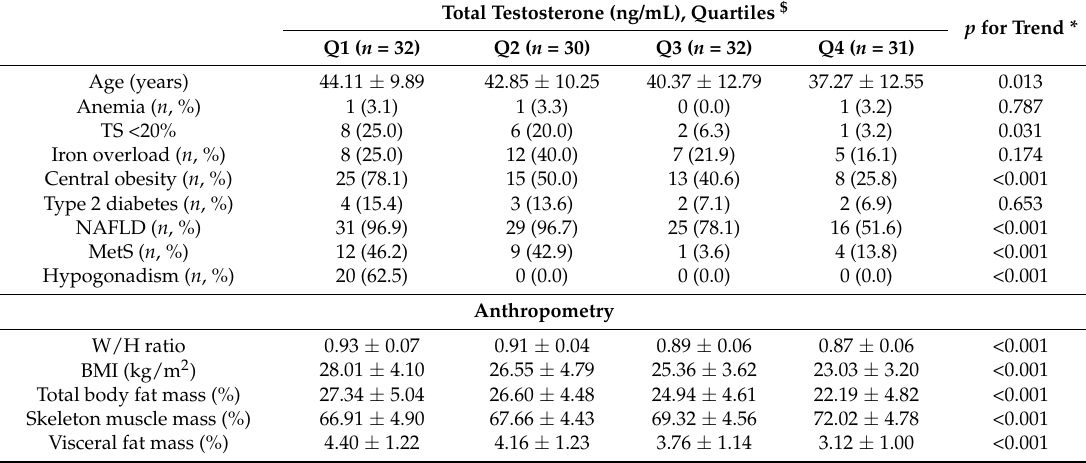
Table 1. Baseline characteristics of the study population according to quartiles of total testosterone levels ( N = 125).